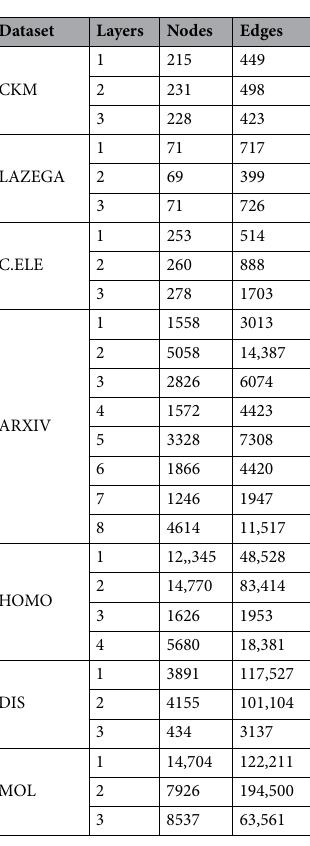
Table 1. Description of the 7 multiplex networks used for the evaluation